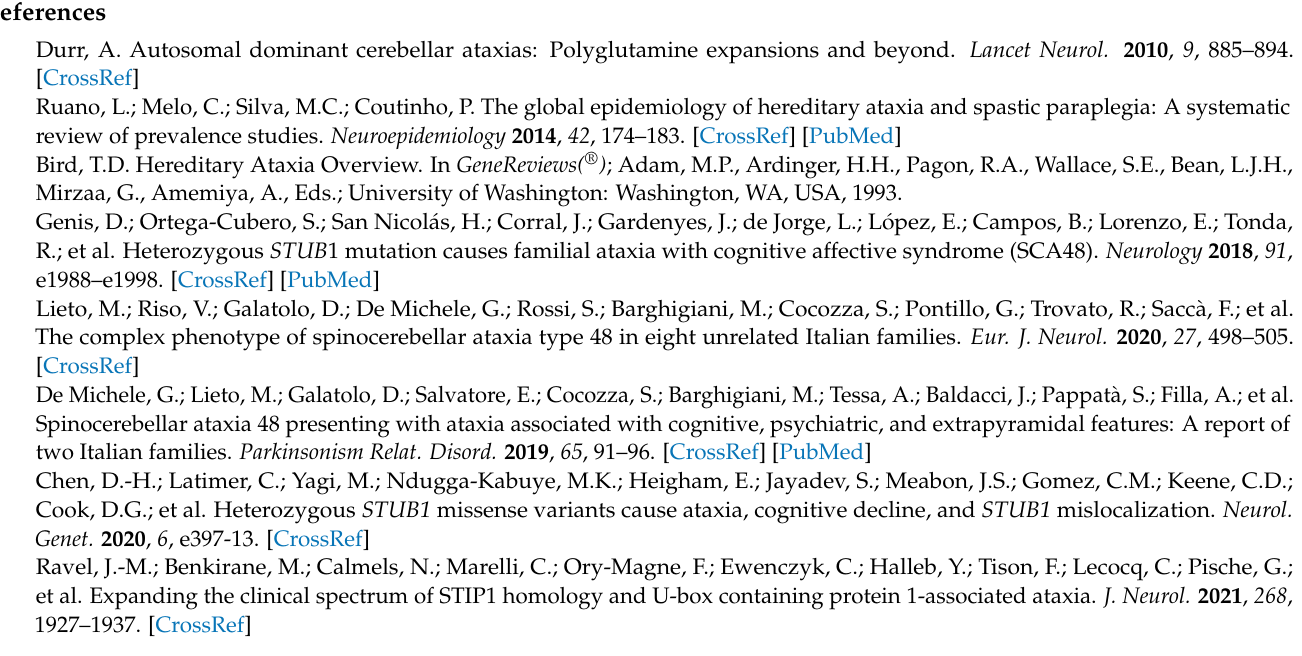
Figure A1. Secondary structure content of wild-type and mutant MBP–CHIP proteins. ( A ) Far-UV spectra were recorded in the range of 0–260 nm. Final graph was prepared using GraphPad Prism after smoothing. ( B ) Estimation of the secondary structure content in mutant MBP–CHIP proteins compared to the wild-type, using BeSTSel.